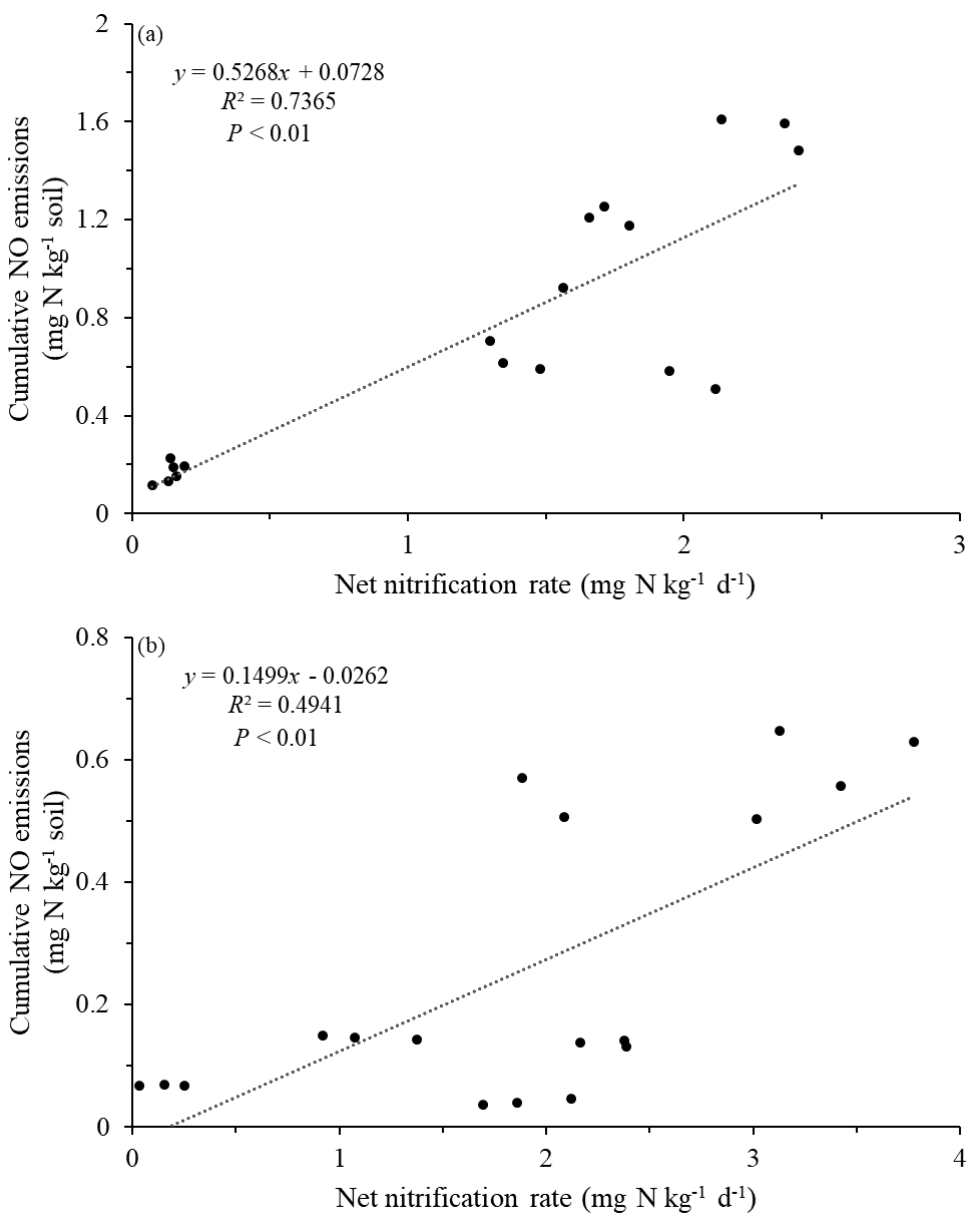
Figure 7. Correlations of soil net nitrification and NO cumulative emissions; ( a ) Changsha, ( b ) Bai- sha.